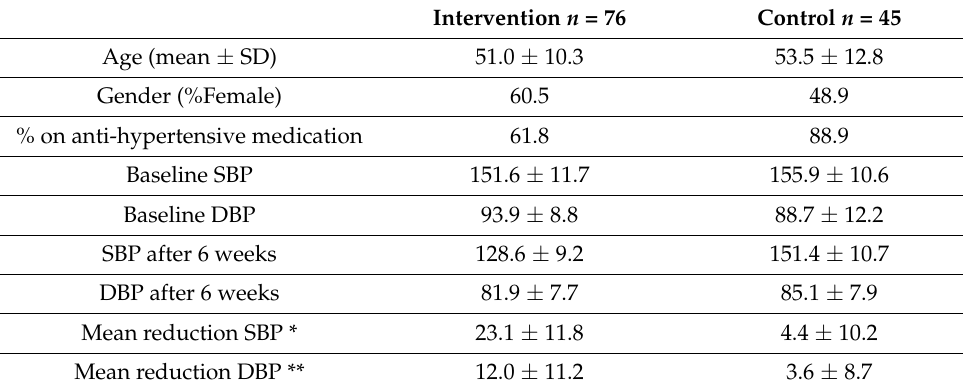
Table 1. Sociodemographic and clinical